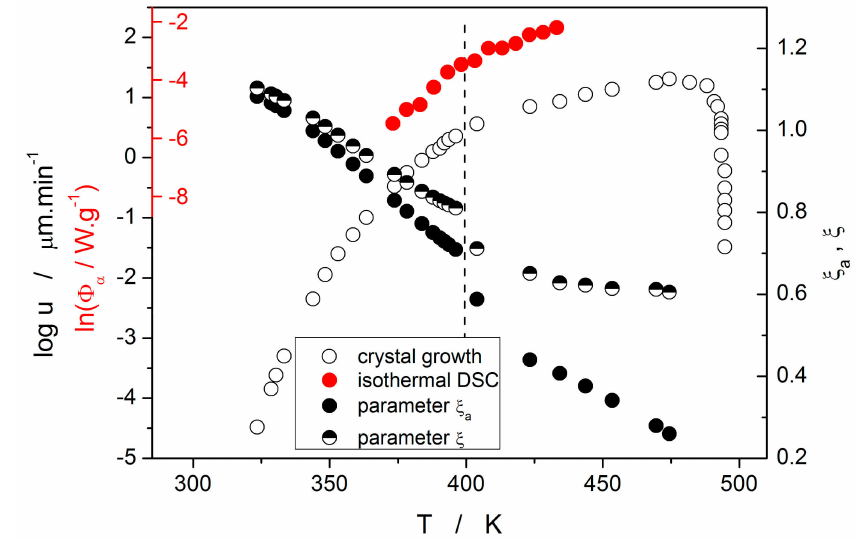
Figure 11. Temperature dependences of decoupling parameters ξ a and ξ (right-hand axis), crystal growth rate u (black outer left-hand axis) and logarithm of heat flow corresponding to α = 0.50 obtained during isothermal DSC experiments (red inner left-hand axis). The vertical dashed line indicates the transition between the spherulitic B and A crystallite